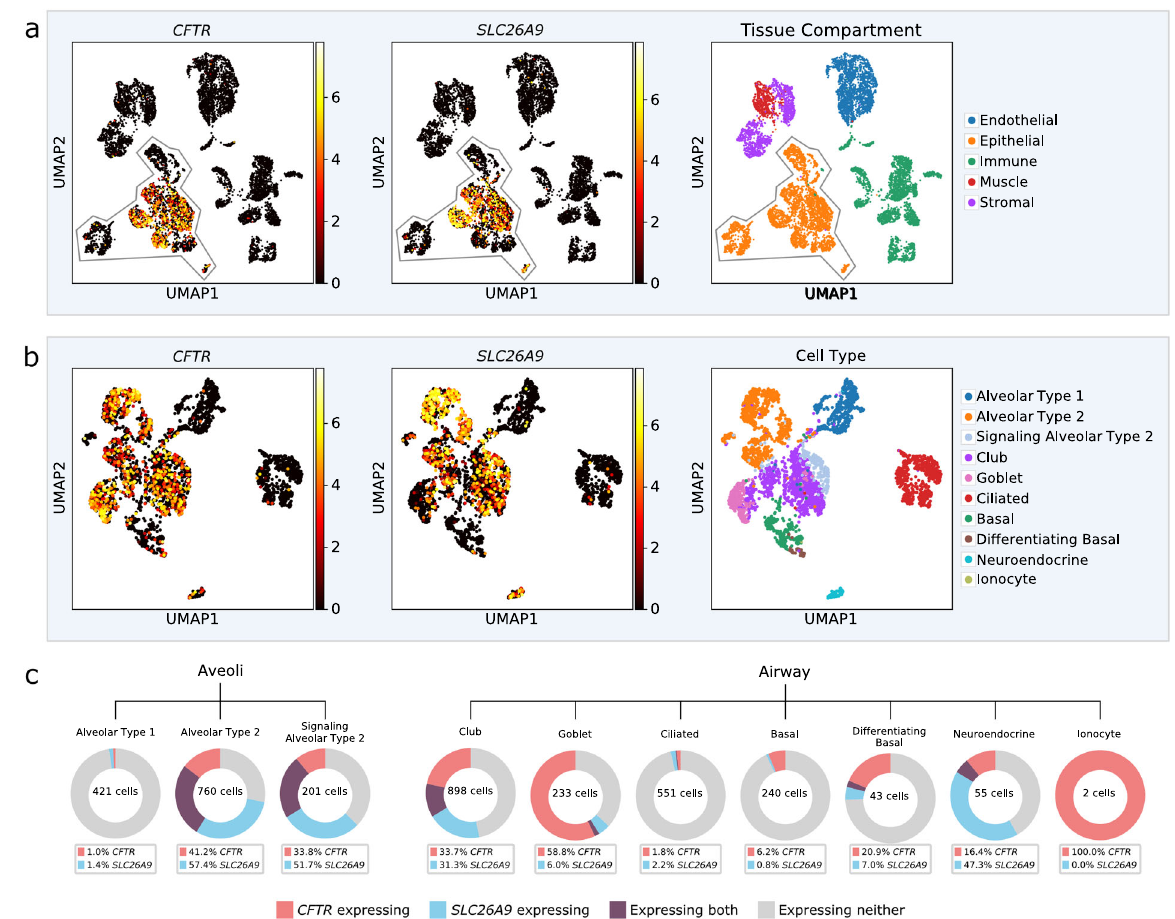
Fig. 4 CFTR and SLC26A9 single-cell expression from the Human Lung Cell Atlas 40 . a Lung cell expression pro fi les from three individuals were clustered by nearest-neighbor and visualized using uniform manifold approximation and projection (UMAP). Normalized and log-scaled RNA counts for CFTR and SLC26A9 are plotted for each cell. Tissue compartment as de fi ned by the Human Lung Cell Atlas is shown; expression of both CTFR and SLC26A9 is primarily restricted to epithelial cells, b UMAP clustering of epithelial lung cells only; cell types were annotated in the Human Lung Cell Atlas. c Breakdown of CFTR and SLC26A9 expression by cell type. Cells were grouped as having CFTR read count > 1 (red), SLC26A9 > 1 (blue) or co-expressing both (purple). Cell total varies and is annotated for each cell